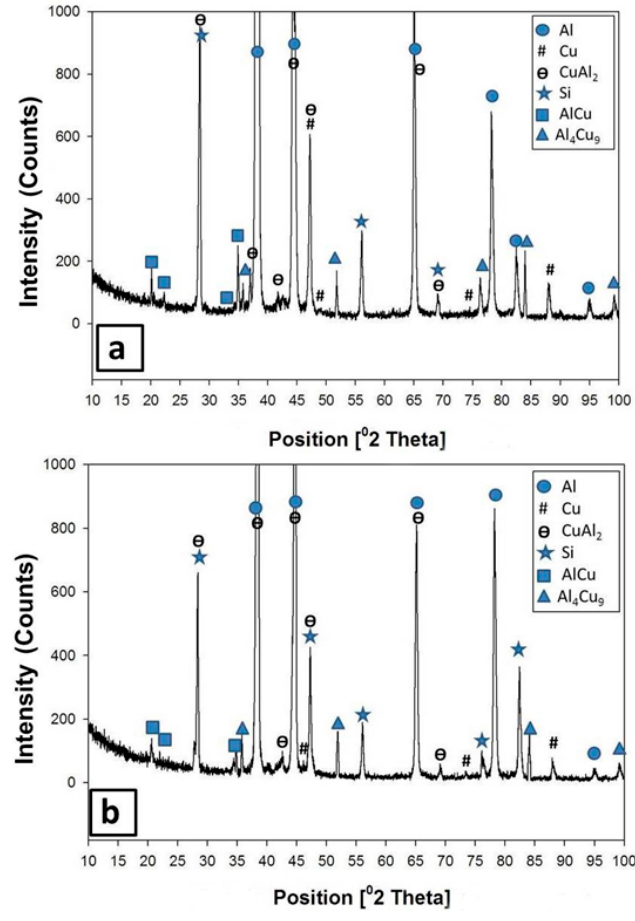
Figure 11. XRD patterns obtained from the formed composite of 6% Cu after the heat treatment at ( a ) 450 °C for 6 h and ( b ) 450 °C for 18 h.